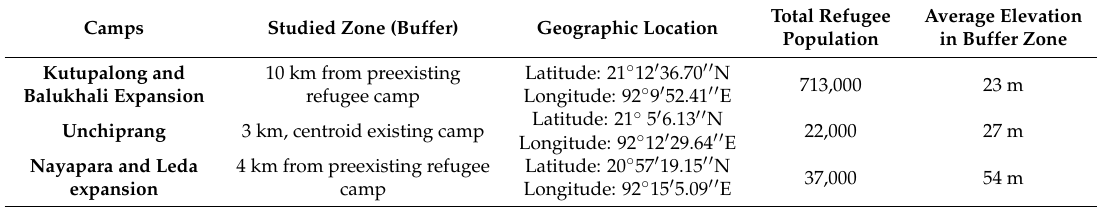
Table 1. Three major concentrations of Rohingya refugee camp sites, their geographical locations, respective population sizes, and the optimal threshold of each buffer zone studied here. The buffer size for each site was determined based on the camp’s aerial expansion in